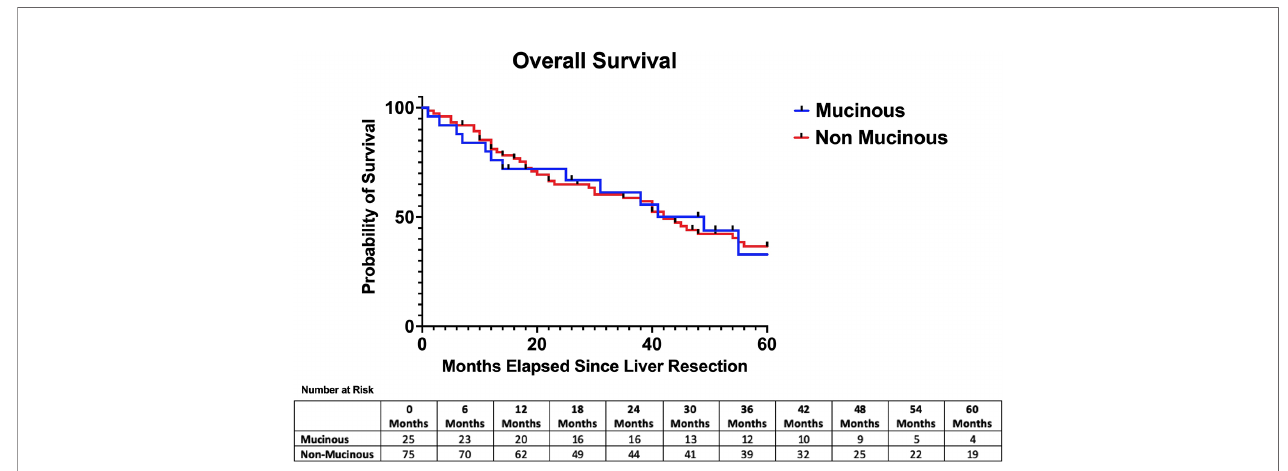
FIGURE 3 | Overall survival after hepatic resection. Median overall survival = 49 months (mucinous) versus 42 months (non-mucinous) p